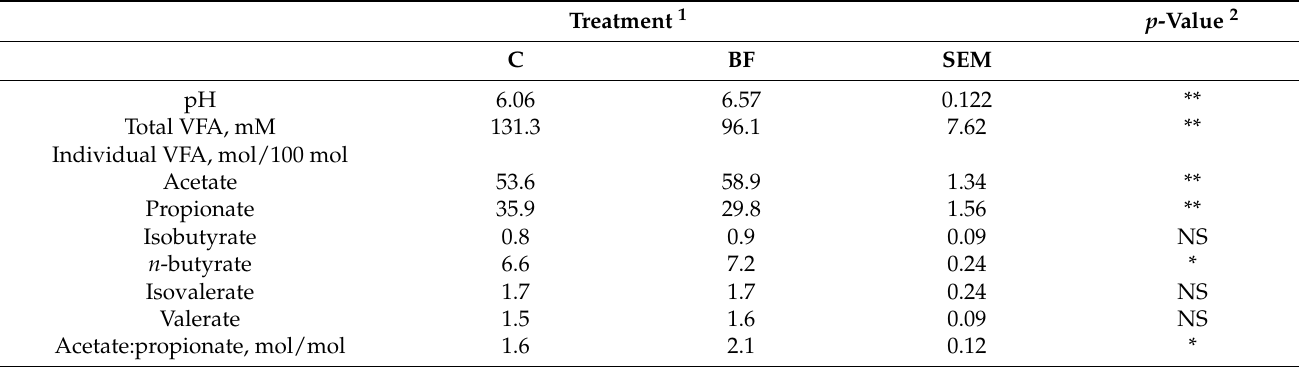
Table 7. Rumen VFA concentration at the slaughterhouse of Holstein bulls fed high-concentrate diets supplemented with citrus